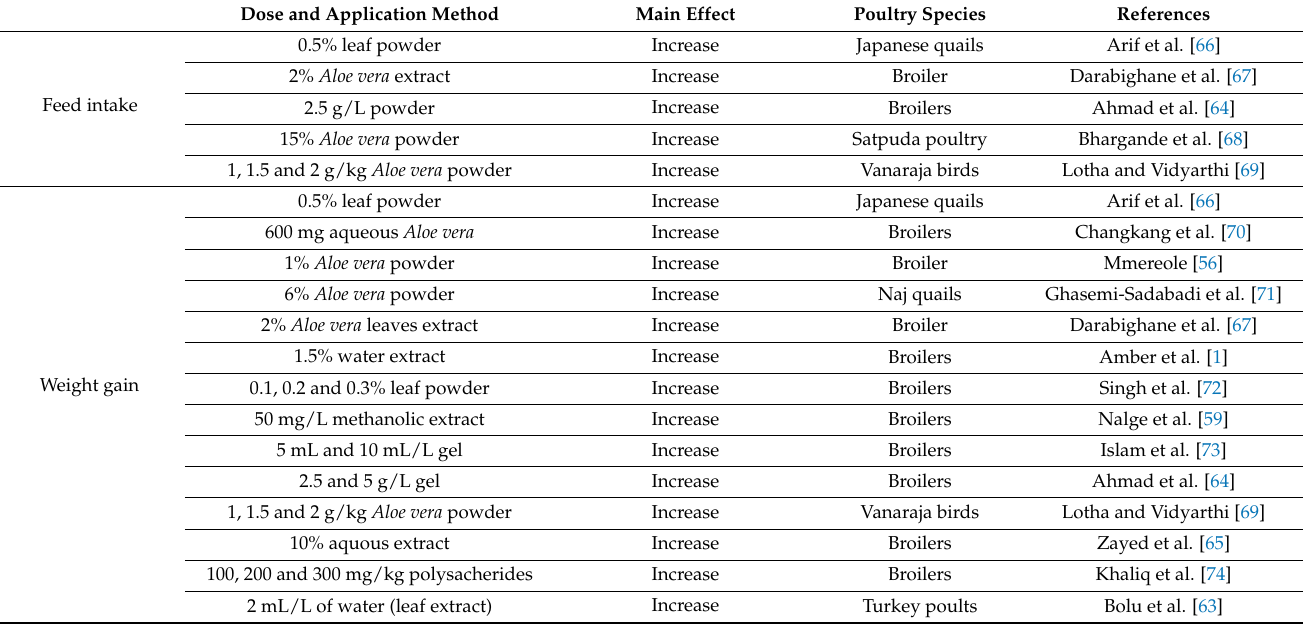
Table 1. Main effects of Aloe vera supplementation on poultry production and